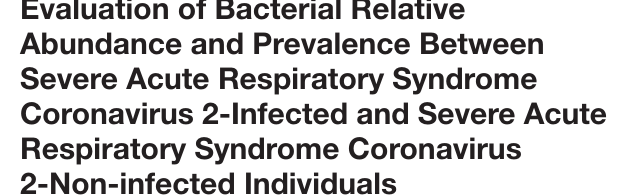
to SARS-CoV-2 infection, as shown in Figure 1 , we adjusted for gender and age group. We conducted a likelihood ratio test to compare the average relative abundance and total prevalence between both groups. The comparison between both datasets revealed that SARS-CoV-2-infected individuals have statistically significant enrichment of Blautia (relative abundance 13.93% in